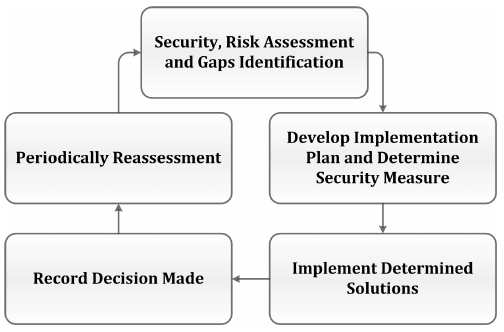
Figure 4. HSS Recommended Compliance